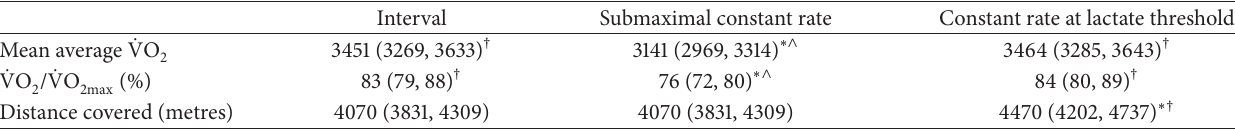
Table 1: Mean average intervals.